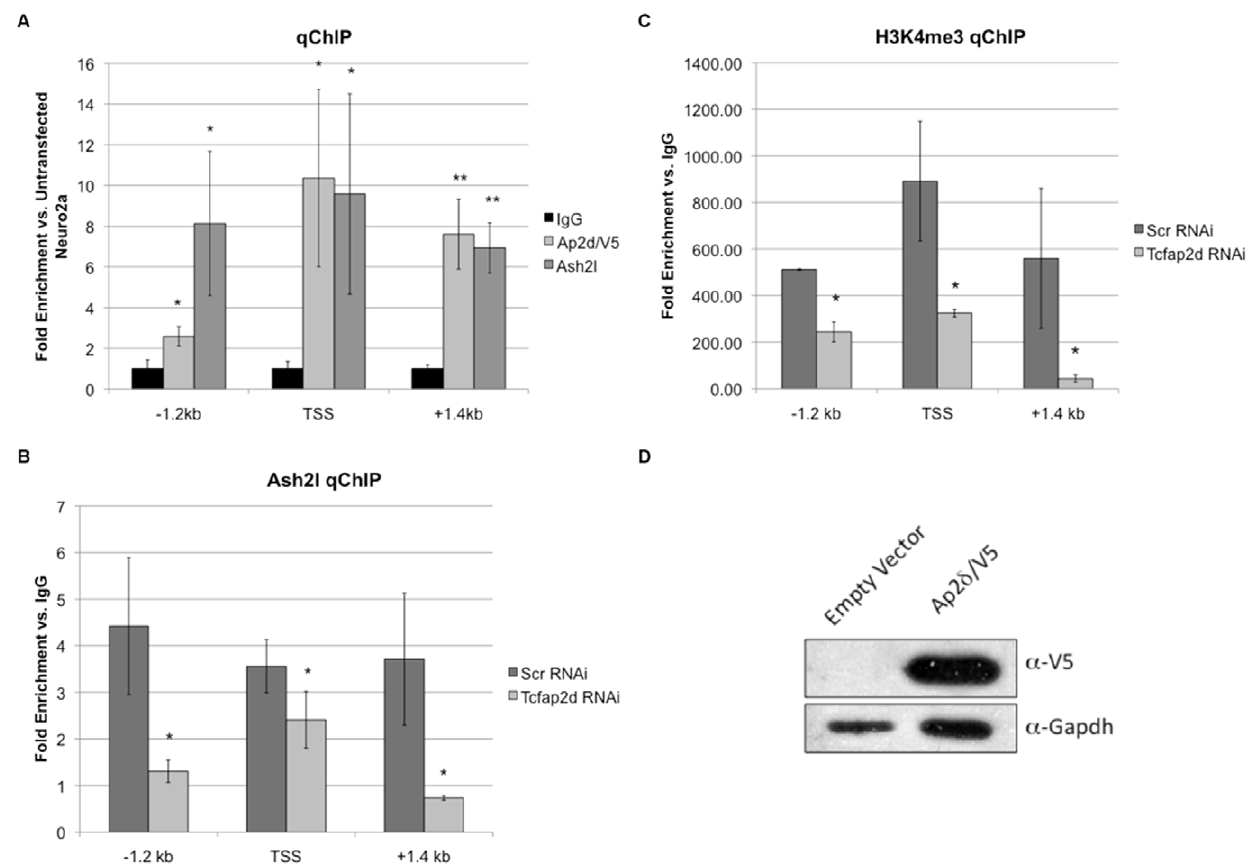
Figure 4. Ap2 d recruits Ash2l-containing HMT complexes to the Fgfr3 locus in Neuro2a cells. ( A ) ( Top ) Ap2 d and Ash2l bind specific regions of the Fgfr3 promoter that are highly enriched in evolutionarily conserved Ap2-binding sites. The sites are located at the transcriptional start site (TSS) and regions , 1.2 kb ( 2 1.2 kb) upstream and , 1.4 kb ( + 1.4 kb) downstream of the TSS. ( Bottom ) Western blot analysis show expression of Ap2 d /V5 in Neuro2a cells transfected with either an empty vector or an Ap2d/V5 expression construct. (B ) Ap2 d downregulation results in decreased localization of Ash2l at the promoter concomitant with reduced HK4me3 ( C ). (D) Real-time PCR analysis shows a specific downregulation of Tcfap2d transcripts in Neuro2a cells treated with Tcfap2d -specific siRNA only. Normalized values were calculated as percentages of transcript levels detected in cells treated with the scrambled control. Significant differences are as indicated with * (p # .05) and ** (p # .005).